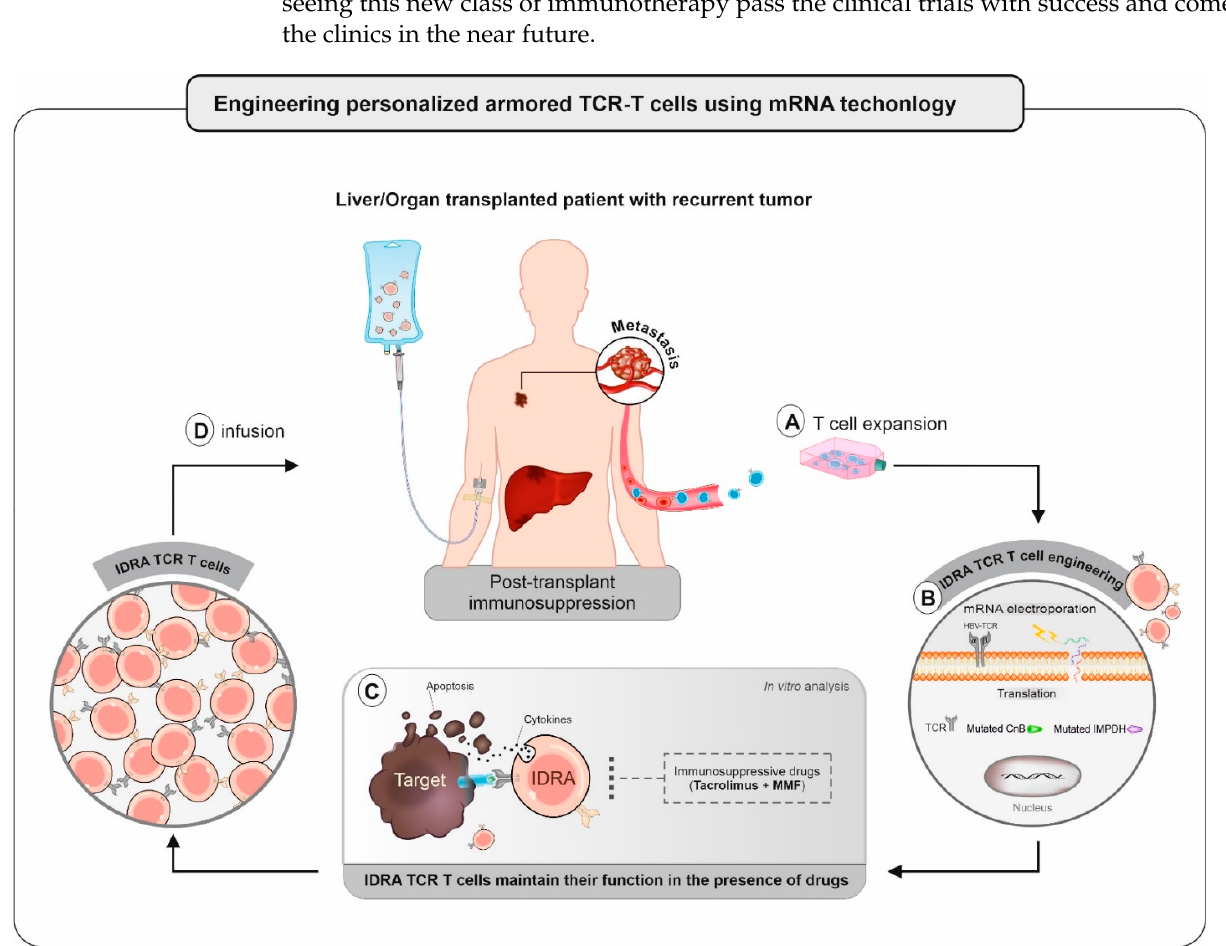
Figure 1. Schematic illustrating the development of IDRA TCR redirected T cells using mRNA technology. ( A ) Expansion and activation of autologous T cells for T cell editing; ( B ) concomitant mRNA electroporation of TCR and mutated forms of CnB, IMPDH transgenes in order to engineer IDRA TCR T cells; ( C ) edited IDRA TCR T cells are able to transiently evade immunosuppression and maintain their function in the presence of drugs using immune assays; ( D ) following quality control, autologous IDRA TCR T cells infused back into the transplanted subject.